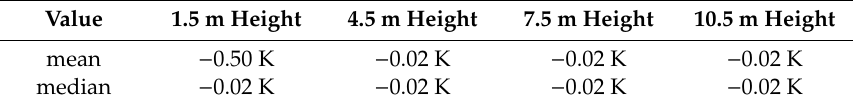
Table 3. Means and medians for next planar cuts of green roof case in the context of the whole atrium interior air temperature.